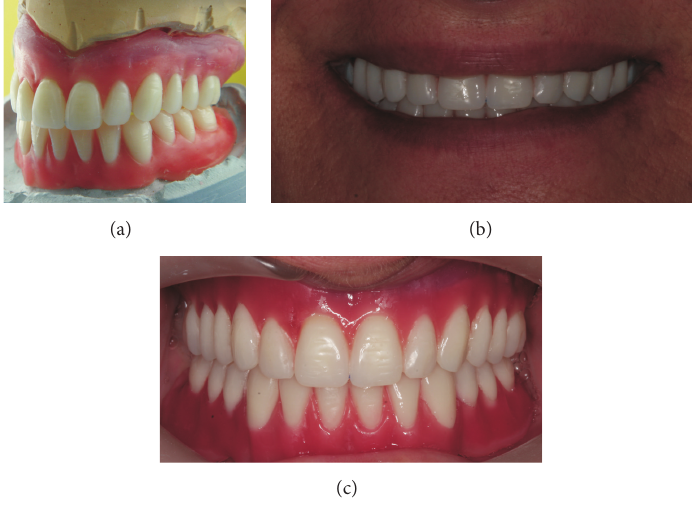
Figure 5: (a, b, and c) Wax-up try-in for determining intermaxillary vertical dimensions and the